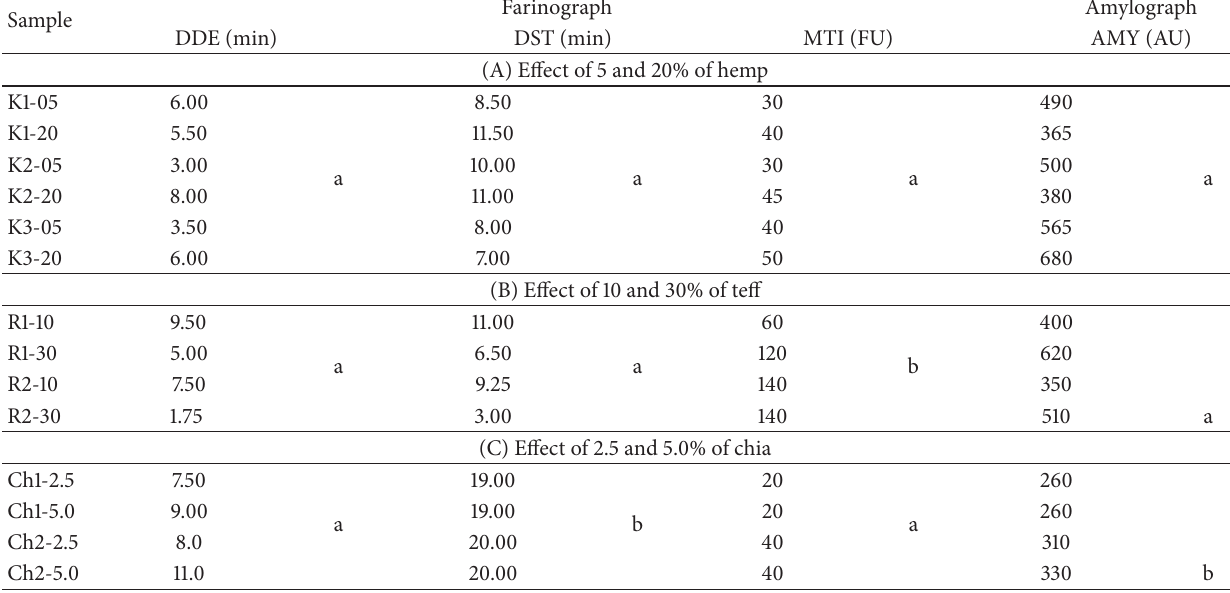
Table 1: Farinograph and amylograph test results of wheat flour composites. Farinograph Sample